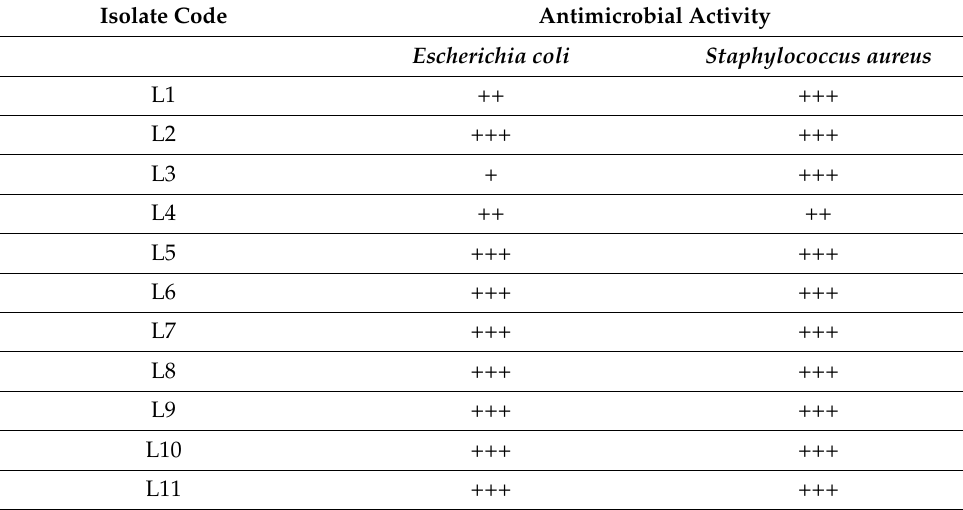
Table 3. Antibacterial activity of Leuconostoc mesenteroides subsp. mesenteroides against two common intestinal